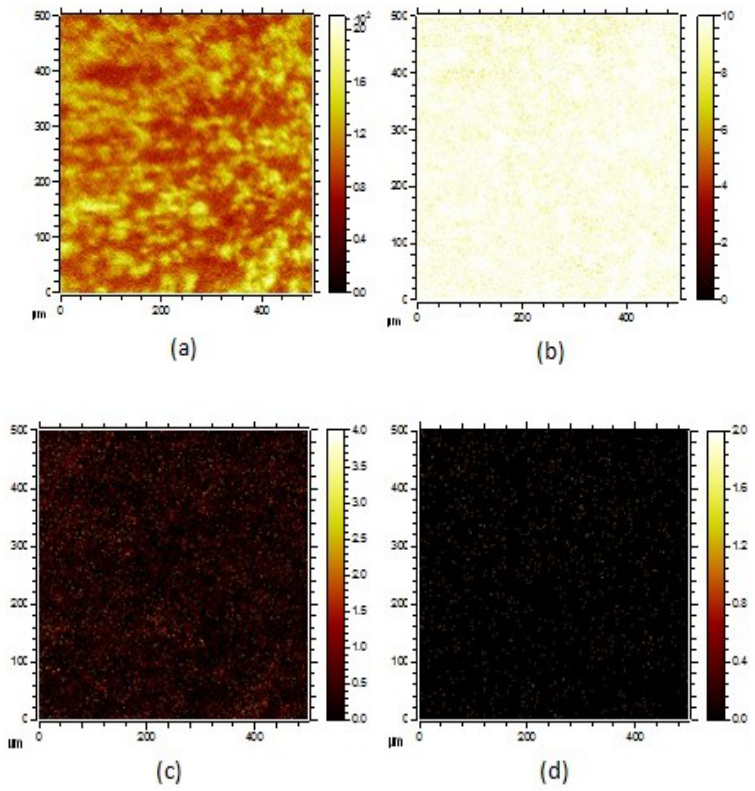
Figure 4. Two-dimensional distributions of ions on the FA surface (500 × 500 µm 2 ) treated with H 2 SO 4 (1 × 10 −3 mol/L) and oleate (2 × 10 −4 mol/L): ( a ) overlap, ( b ) PO 3− , ( c ) SO 4− , and ( d ) CaO − .